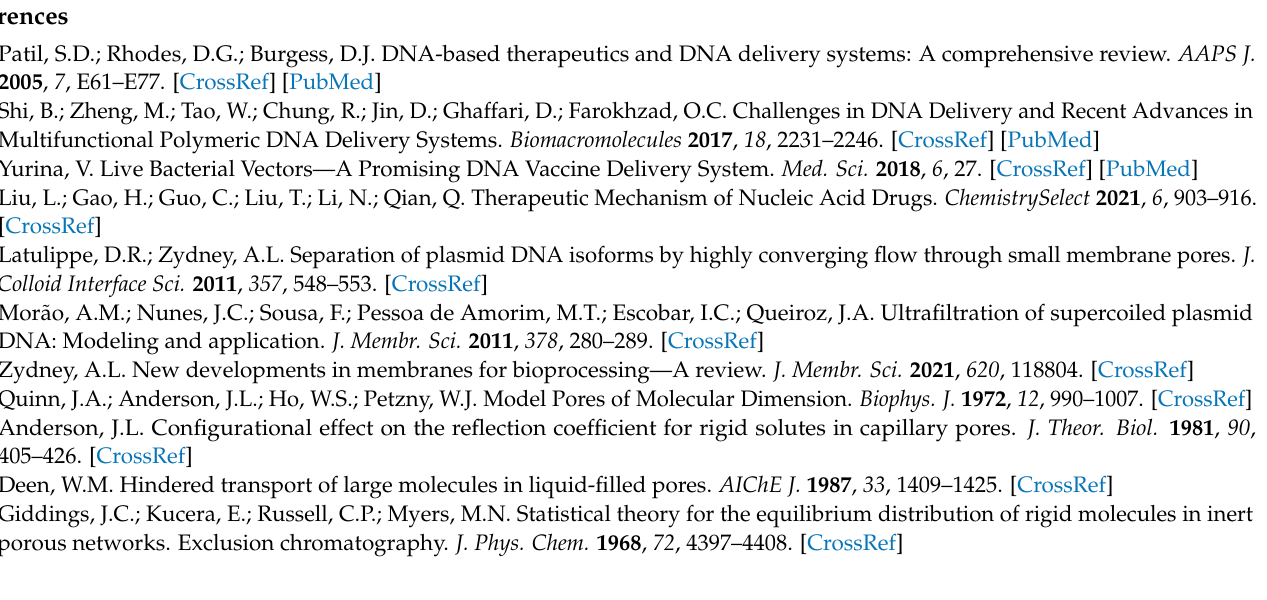
Figure S3: Hydrodynamic radius of poly(dT 60 ) ssDNA at different NaCl concentrations from the measured diffusion coefficients. Table S1: Coefficients in the solution of the linearized Poisson Boltzmann equation (Equations (6) and (S1)). Table S2: Results from Filtration Experiments used to develop Equation